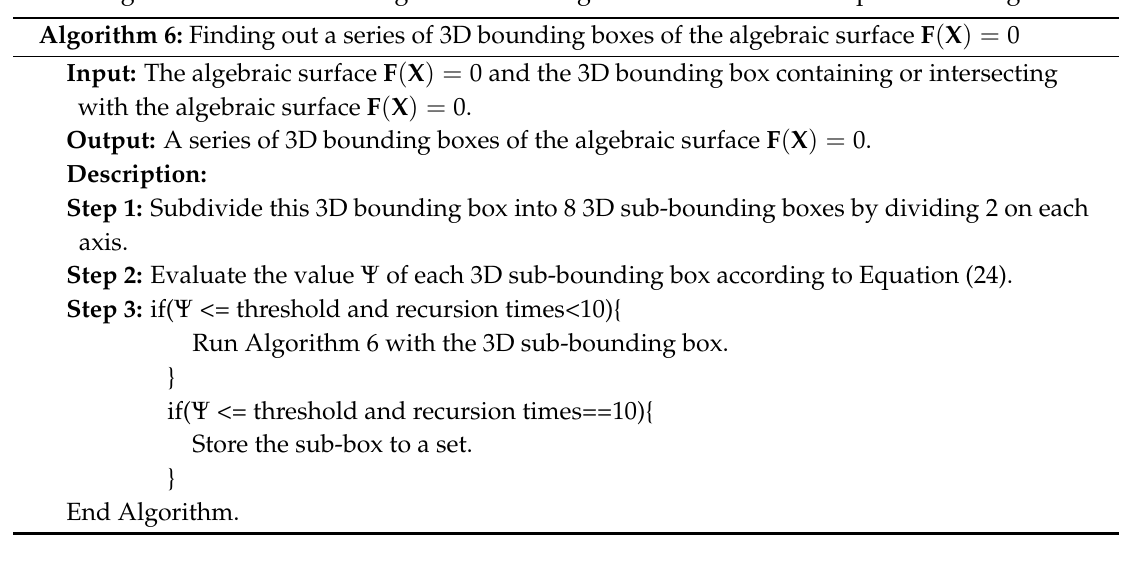
Algorithm 6: Finding out a series of 3D bounding boxes of the algebraic surface F ( X ) =